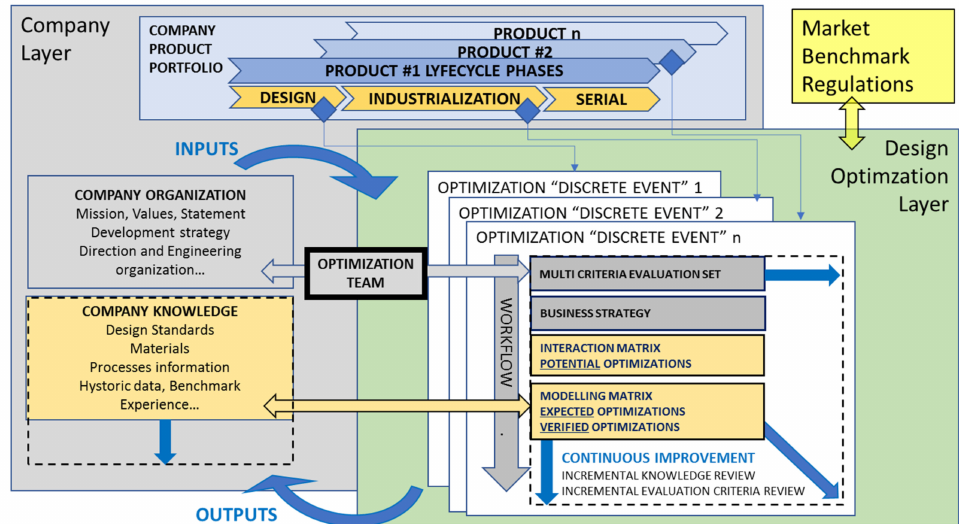
Figure 2. Design optimization “layer” compatible with any company size and organization, and applicable at any product lifecycle milestone. Blue arrows represent the “incremental” methodology, continuous improvement, and knowledge capture philosophy.